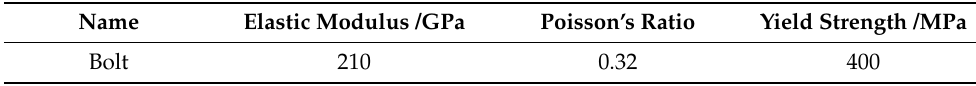
Table 2. Mechanical parameters of bolt.